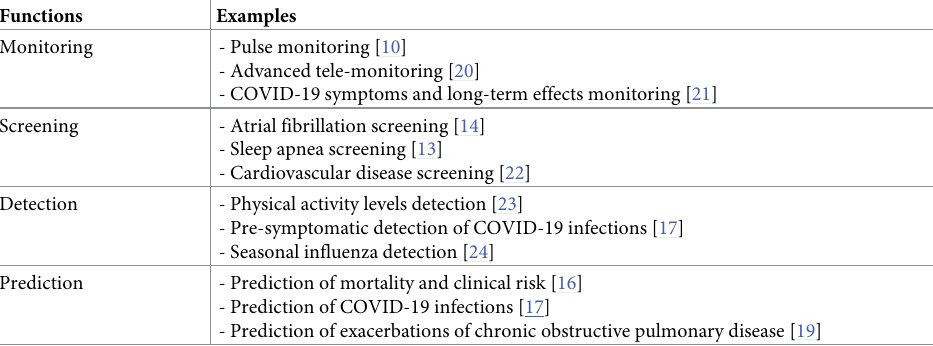
Table 1. The main functions served by wearables for health, with examples.